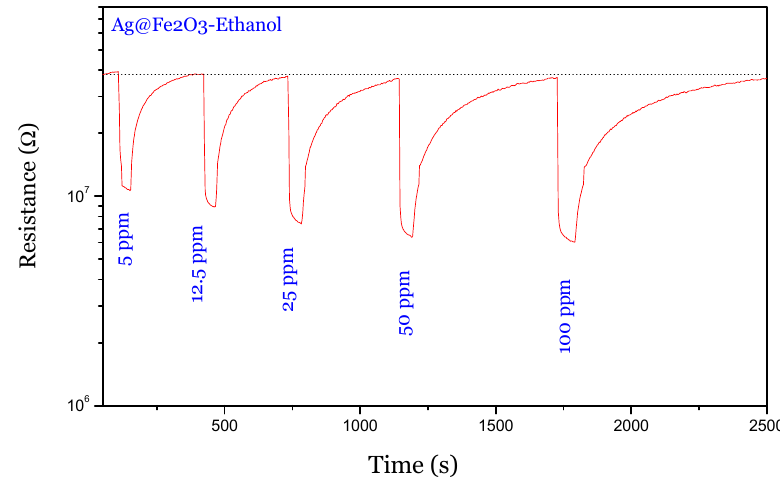
Figure 6. Sensing response of Ag@ α -Fe 2 O 3 towards different concentrations of ethanol vapor at 250